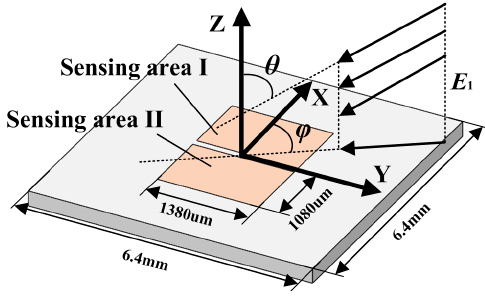
Figure 2. Simulation model for the response of 1D EFSC to a 3D electric field with different directions.